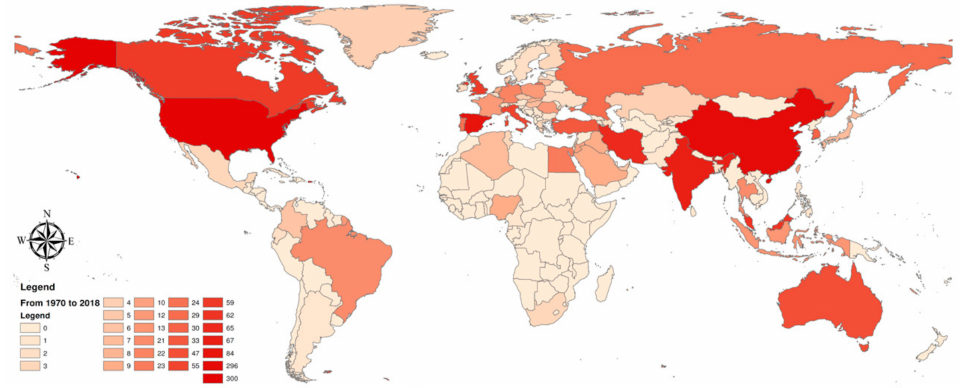
Figure 3. Color-scale map representing the scientific interest as the number of publications from the 1970s up until 2017 for each Country.